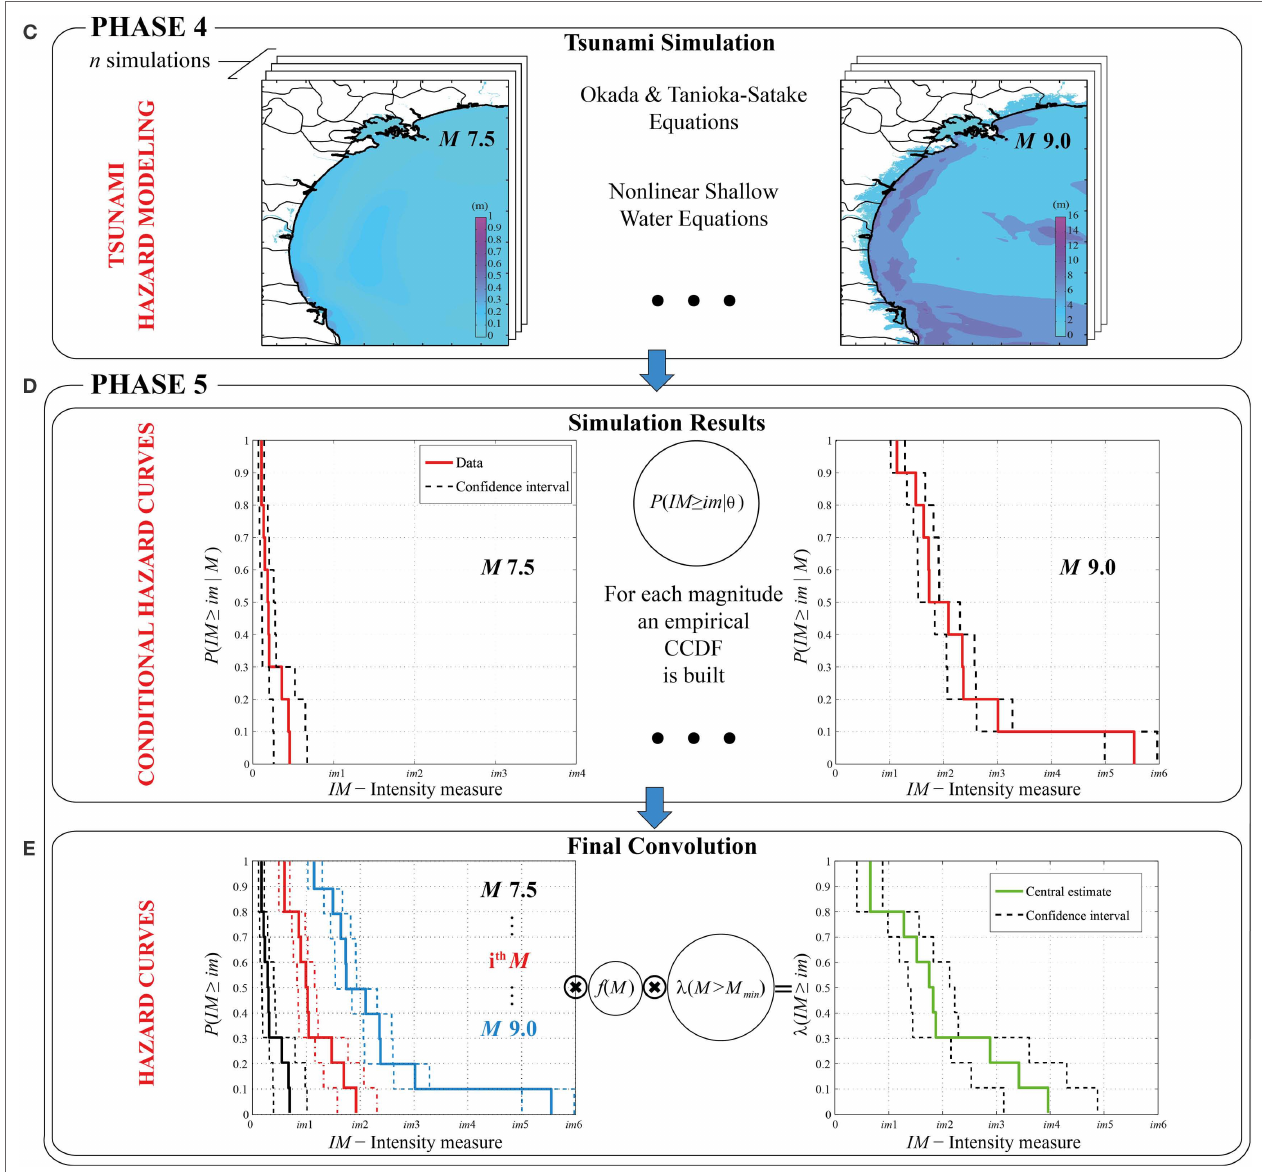
FIGURE 2 | Computational framework for probabilistic earthquake–tsunami hazard analysis . (A) Scenario generation. (B) Seismic hazard modeling. (C) Tsunami hazard modeling. (D) Conditional hazard curves. (E) Hazard curves.